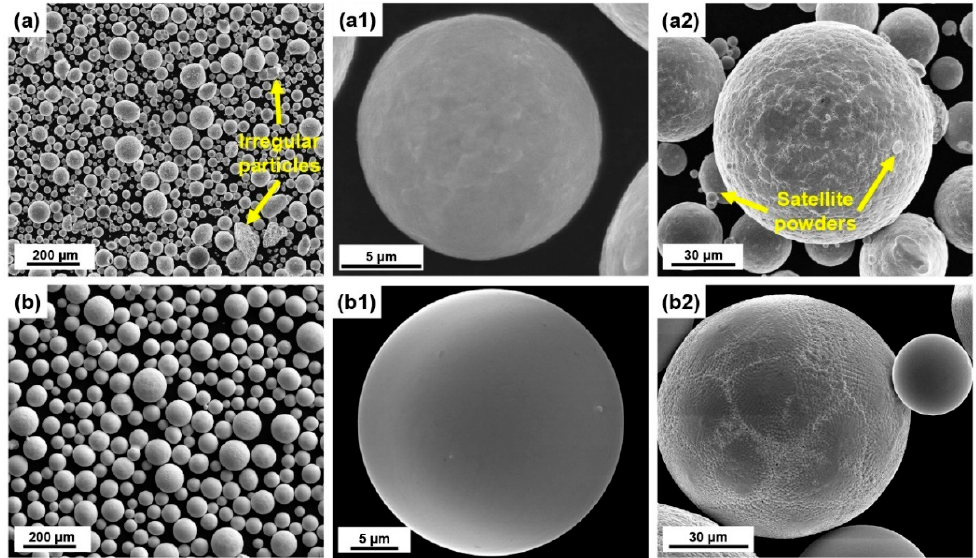
Figure 4. SEM images of the spherical TaNbTiZr RHEA powders at different magnifications: ( a , a1 , a2 ) the EIGAed powders and ( b , b1 , b2 ) the PREPed powders.